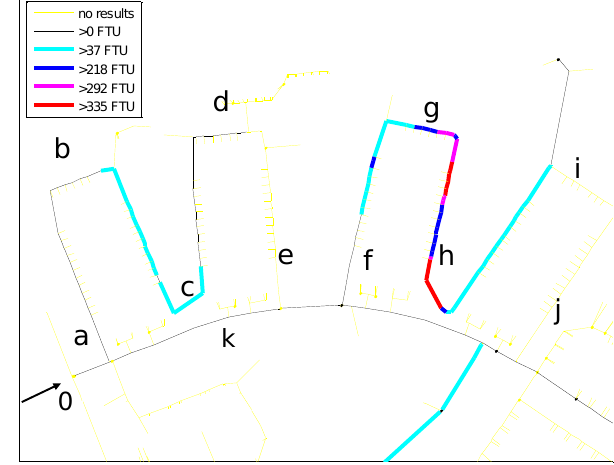
Figure 4. Spatial distribution of turbidity measurement in the Purmerend test area.